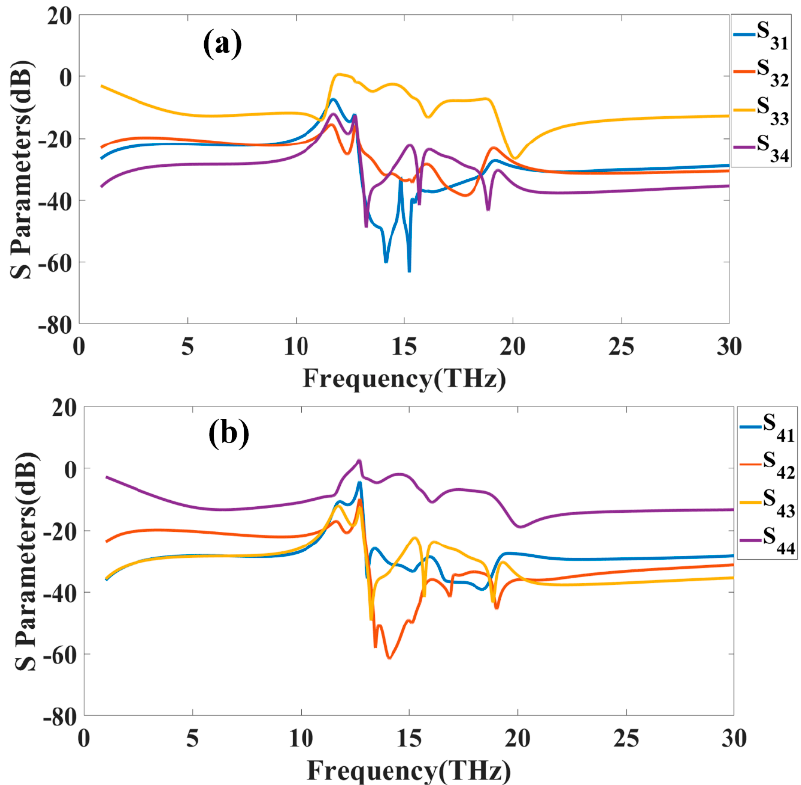
Figure 2. Calculated S-parameters for the Type-1 antenna (2 × 2 structure) by considering ( a ) port-1 and ( b ) port-2 as exciting ports.